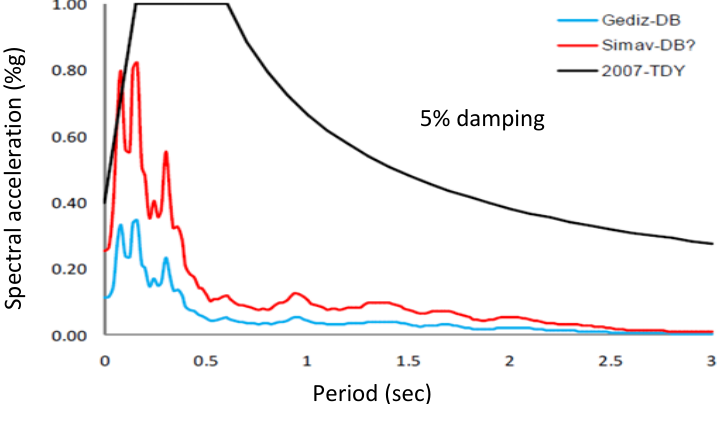
Figure 7. Spectral acceleration for the TEC [9] Z3 soil class and spectral accelerations for ground motions (EW) recorded at Gediz and Simav stations during the Simav earthquake